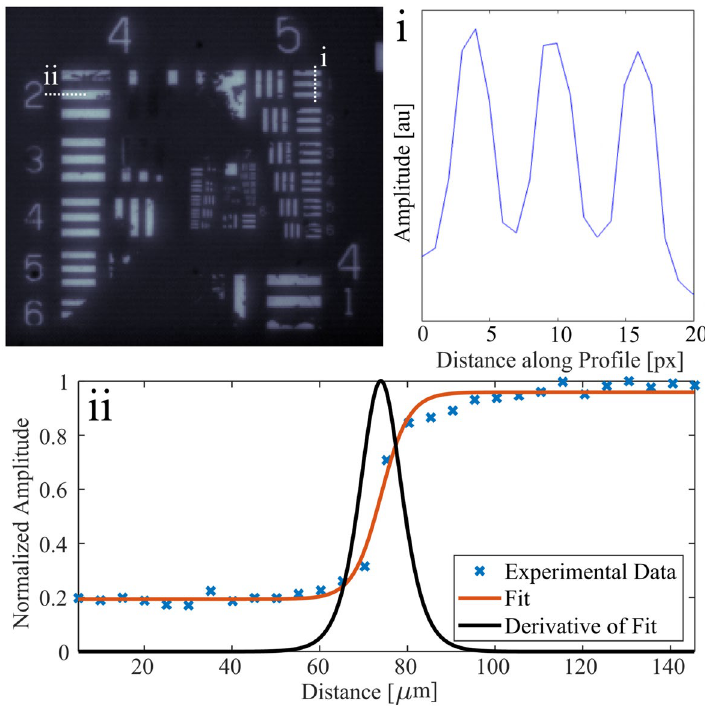
Figure 1. Image of a 1951 USAF resolution test target with extraction of: ( i ) line-pair width profile used to determine effective pixel size, and ( ii ) edge-spread measurement across a target edge for lateral resolution